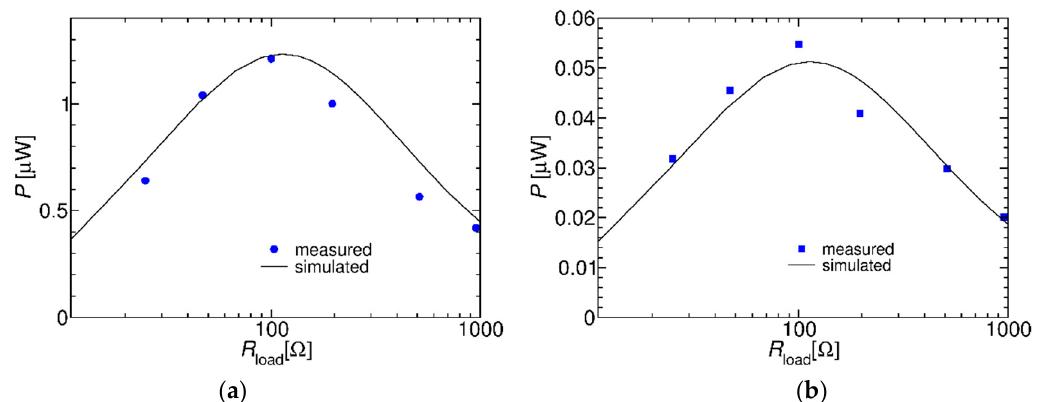
Figure 3. The DC power generated by a folded TEG module of 11 elements as a function of load resistance. Measured and simulated results for ( a ) Δ T = 49 K; ( b ) Δ T = 10